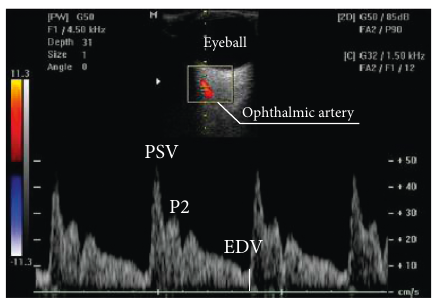
Figure 2: Doppler velocimetry of ophthalmic artery (OA), with identification of the pulse wave velocity (PWV) of the OA. The X -axis represents the time (seconds), and the Y -axis represents the flow velocity (cm/s). A rapid increase in velocity is observed, with a peak systolic velocity (PSV), followed by a rapid fall, and a new velocity rise with the formation of a second rounded systolic peak (P2), followed by the aortic notch, which closes the systolic cycle. Then, there is an increase in velocity with for- mation of the diastolic phase of the PWV, which ends with the end-diastolic velocity (EDV). The P2/PSV ratio is referred to as peak ratio